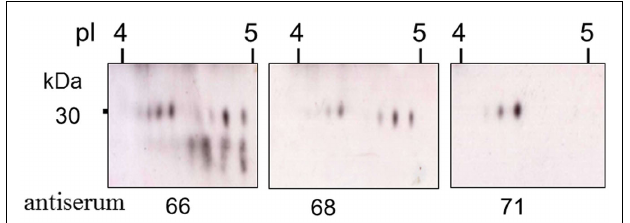
FIGURE 12 | Different sea urchins express different arrays of Sp185/333 proteins. Western blots of coelomic fluid from 13 different sea urchins sampled 96h after challenge with LPS show different arrays of Sp185/333 proteins.The blots were immunostained with an equal mixture of the three different anti-Sp185/333 sera (see legend for Figure 10 ). Reprinted from Dheilly et al. (2009) with permission from the American Association of Immunologists, Inc., copyright